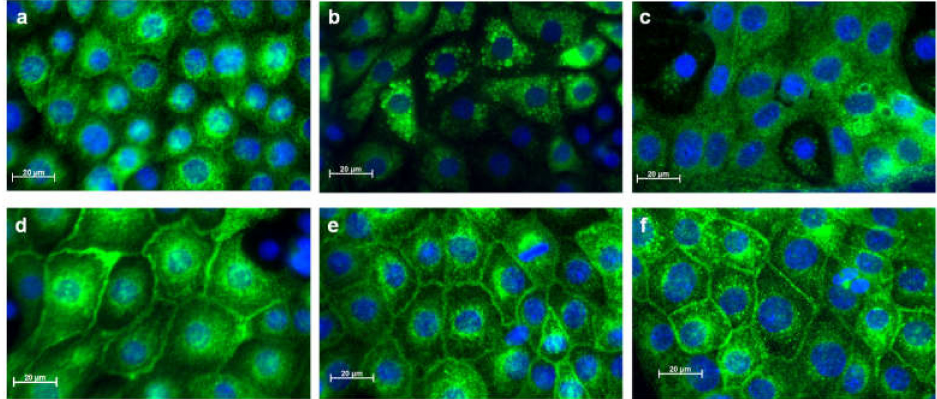
Figure 11. Treatment with dbcAMP prevents the accumulation of Aqp2 in lysosomal structures. IMCD cells were grown on coverslips and were left untreated ( a ), incubated with bafilomycin (100 nM / 24 h, b ), with chloroquine (10 µ M / 24 h, c ), incubated in the presence of dbcAMP (500 µ M / 24 h, d ), with dbcAMP together with bafilomycin ( e ), or dbcAMP together with chloroquine ( f ). The localization of Aqp2 was analyzed by immunofluorescence using an anti-Aqp2 antibody and an Alexa-488-labeled secondary antibody. The nuclei were stained with diamidino phenylindole (DAPI). Images were taken using a Zeiss Axiovert Observer